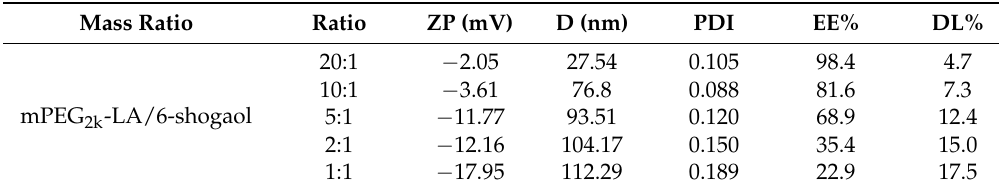
Figure 1. Transmission electron microscope ( A ) and the dynamic light scattering ( B ) results of 6 ‐ shogaol loaded micelles (SMs). [10/1, the mass of methoxypolyethylene glycol (MW = 2000) ‐ linoleate acid conjugate (mPEG 2k ‐ LA)/6 ‐ shogaol]. Table 1. Physicochemical characterization of the micelles made of mixtures of 6 ‐ shogaol and methoxypolyethylene glycol (MW=2000) ‐ linoleate acid conjugate (mPEG 2k ‐ LA) (mean values ± standard deviation, n = 3): measurement of mean diameter (D), Zeta potential (ZP) and polydispersity index (PDI), entrapment efficiency (EE) and drug loading (DL).